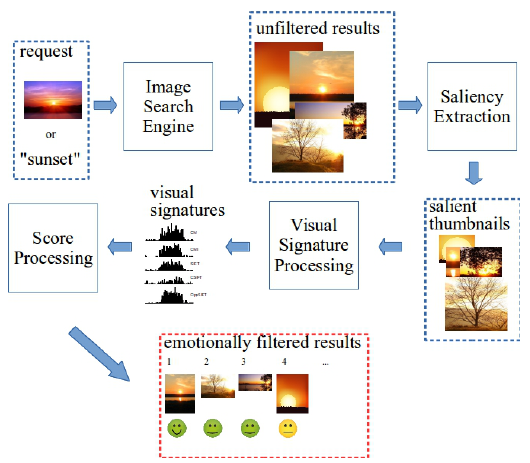
Figure 1. Global emotional filtering